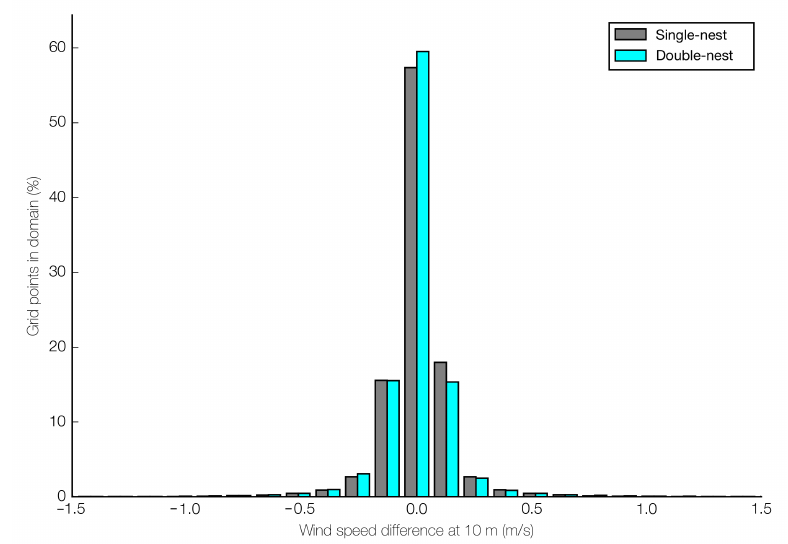
Figure 2. Distribution of 10-m wind-speed point-wise differences between the control (no-SKEB) and first ensemble member after 3h of simulation, for both ensembles (see key). A positive value indicates that SKEB has increased the wind speed at a given gridpoint. The y-axis indicates percentage of total grid points.